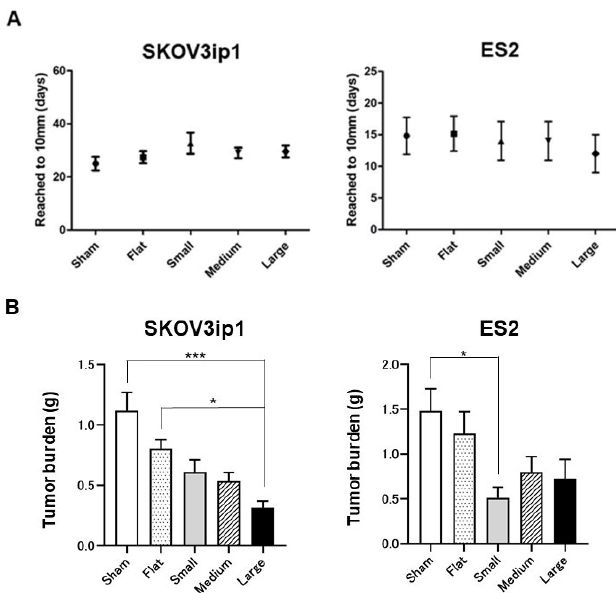
Figure 2. Effects of HCFs on tumor growth in ovarian cancer. ( A ) Number of days to achieve a tumor size of 10 mm. The number of days to achieve a tumor size of 10 mm was the control tumor (sham ; ● ) for 25.0 ± 5.2, flat films (flat ; ■ ) for 27.4 ± 5.2, HCFs with small pores (small; ▲ ) for 32.7 ± 9.7, HCFs with medium pores (medium; ▼ ) for 29.0 ± 4.5, and HCFs with large pores (large; ◆ ) for 29.6 ± 5.5 in SKOV3ip1, and sham (●) for 14.8 ± 6.5, flat ( ■ ) for 16.0 ± 7.2, small ( ▲ )for 14.0 ± 6.1, medium ( ▼ ) for 14.0 ± 6.1, and large ( ◆ ) for 12.0 ± 5.2 in ES2, Values of the days are shown as the mean ± SE. ( B ) The tumors formed form SKOV3ip1 were removed and weighed 24 days after surgery in mice, while the tumors formed from ES-2 were removed and weighted 21 days after surgery in mice. Values of tumor weights are shown as the mean ± SE. Significant differences are indicated by asterisks. ***, p < 0.001, *, p < 0.05.